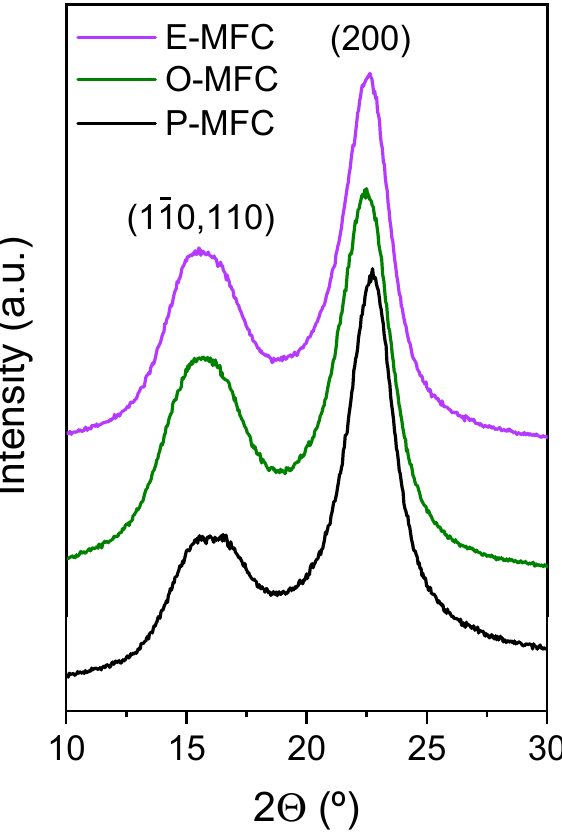
Figure 2. X-ray diffractograms of O-MFC, P-MFC and E-MFC, respectively.